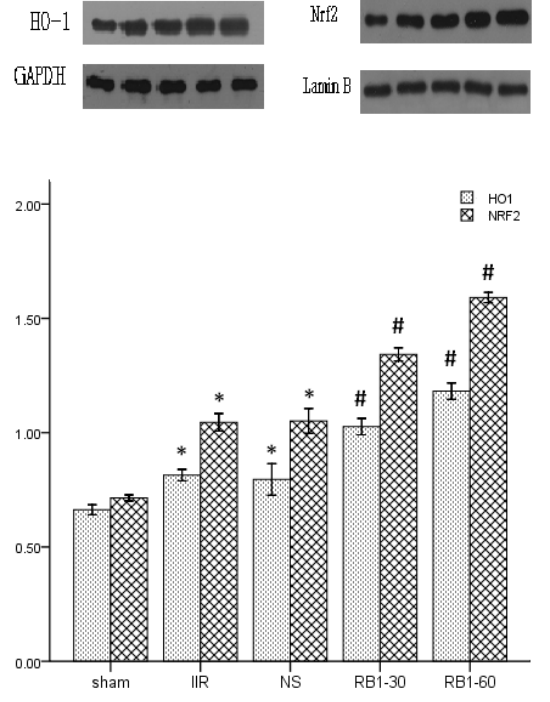
Figure 5. The expressions of Nrf2 and HO-1 in the renal tissues in the groups by western blot. * p < 0.05 vs. sham group, # p < 0.05 vs. IIR group.